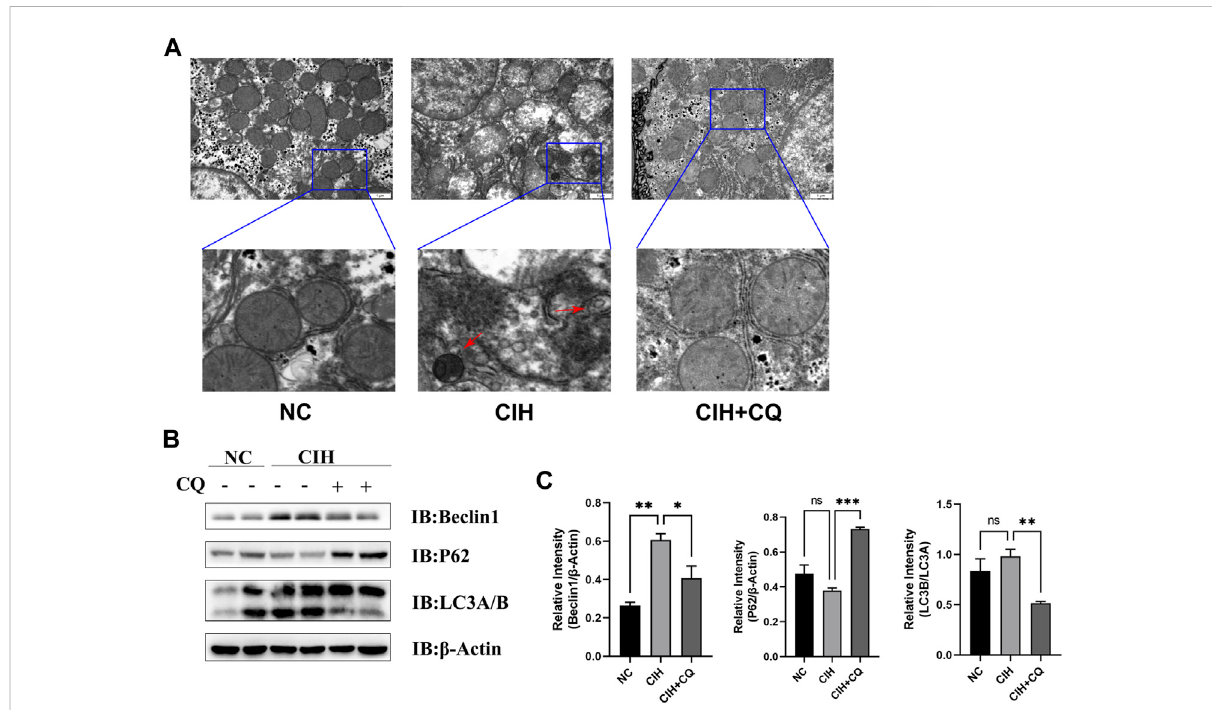
FIGURE 2 OSA model mice exhibit excess autophagic activity and autophagic fl ux. (A) CIH induced increases in autophagosome formation and accumulation in the CIH and CIH + CQ group. (B) Hepatic Beclin1, P62, and LC3A/B protein levels were compared among groups. (C) Beclin1 and P62 proteinlevelswerenormalized to β -Actin levels,and theLC3B/Aratio was assessed indifferentgroups (Red arrow: autophagosomes; * p < 0.05, ** p < 0.01, *** p <